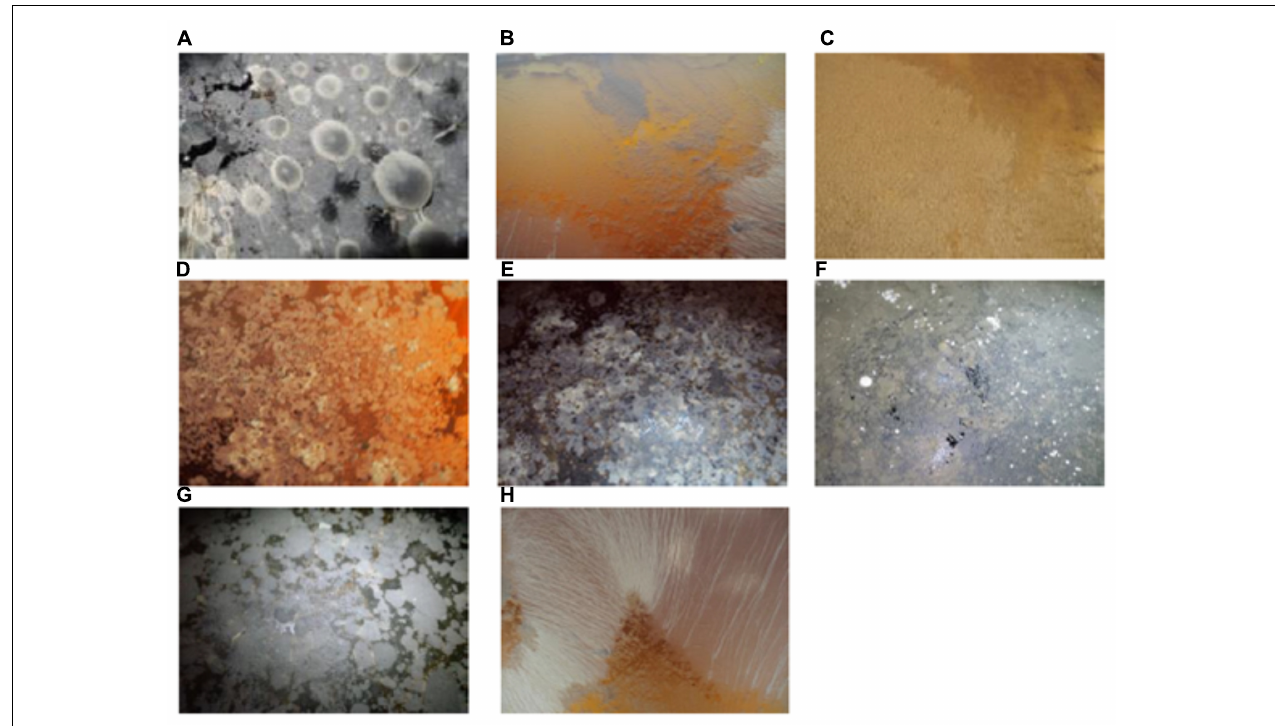
FIGURE 1 | Flor yeast velum characteristic: (A) gray velum with blisters; (B) pink velum with wrinkles; (C) yellow thick and granular velum; (D) mix of white, brown and yellow velum; (E) mix of gray, black, yellow and white velum; (F) gray fine and smoothy velum; (G) black velum with islands; (H) white velum with wrinkles.